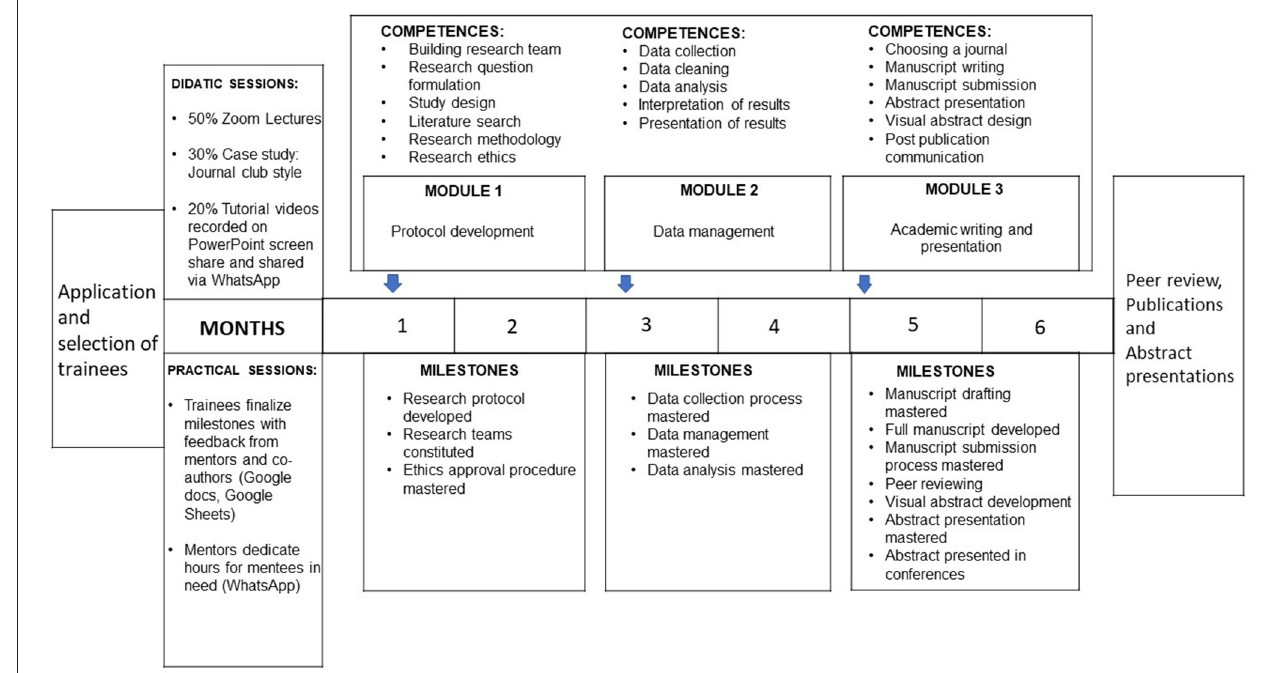
FIGURE 1 | The Association of Future African Neurosurgeons Research Incubator Program